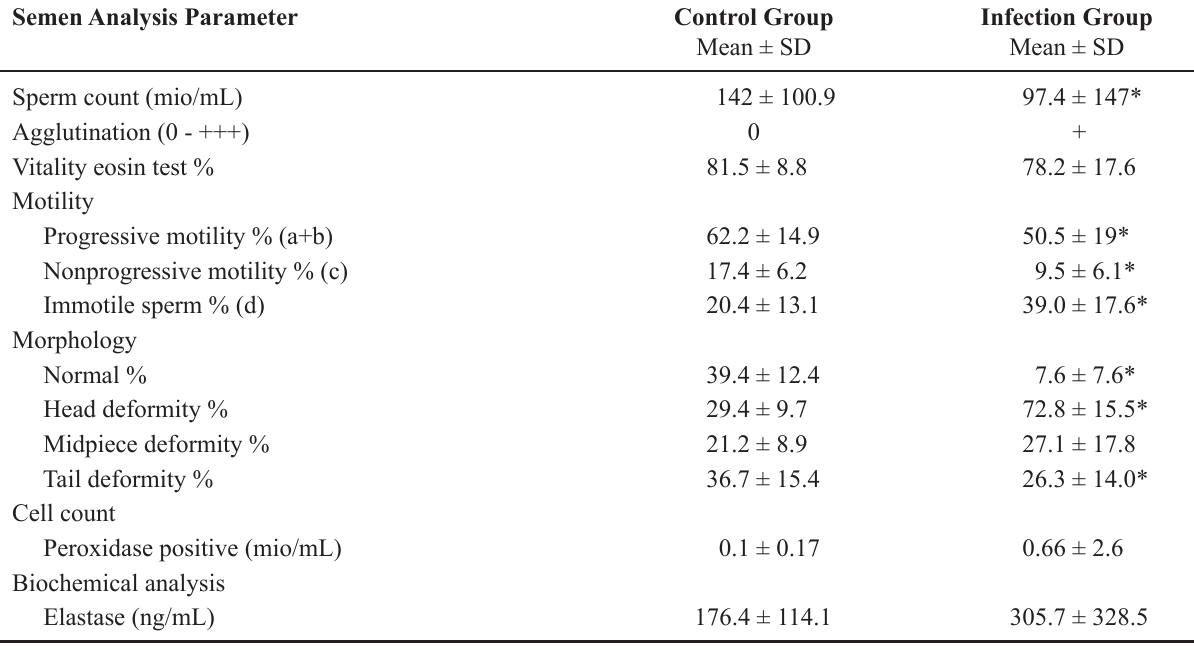
Table 2 – Physical and cytomorphological analysis of the ejaculate in controls (N = 40) and patients (N = 71).